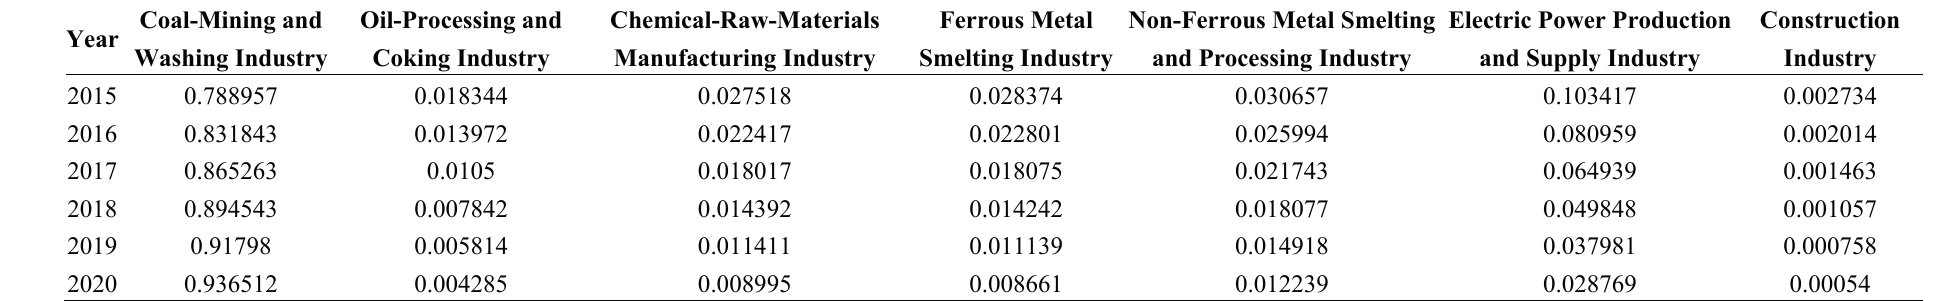
Table19. Predicted values of the capital investments needed per 10 thousand yuan (10 thousand